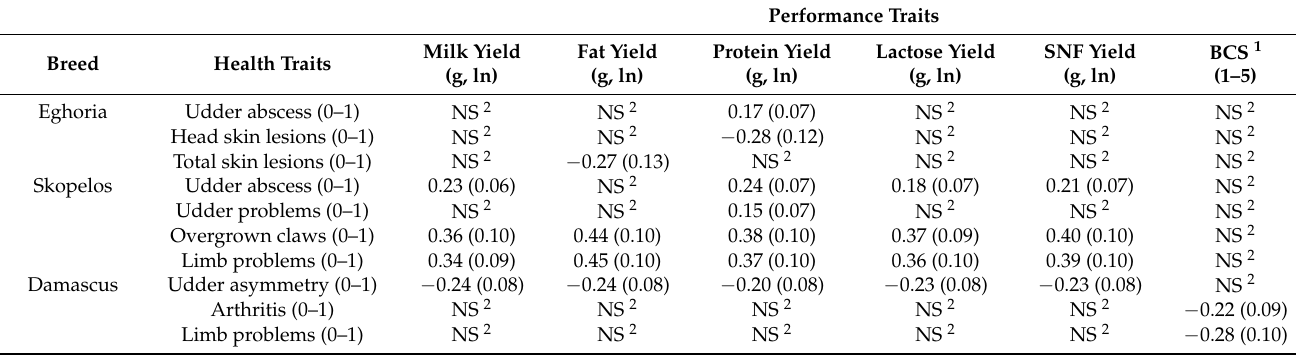
Table 8. Statistically significant ( p < 0.05) animal correlations (standard error in parentheses) between welfare and performance traits in Eghoria, Skopelos, and Damascus